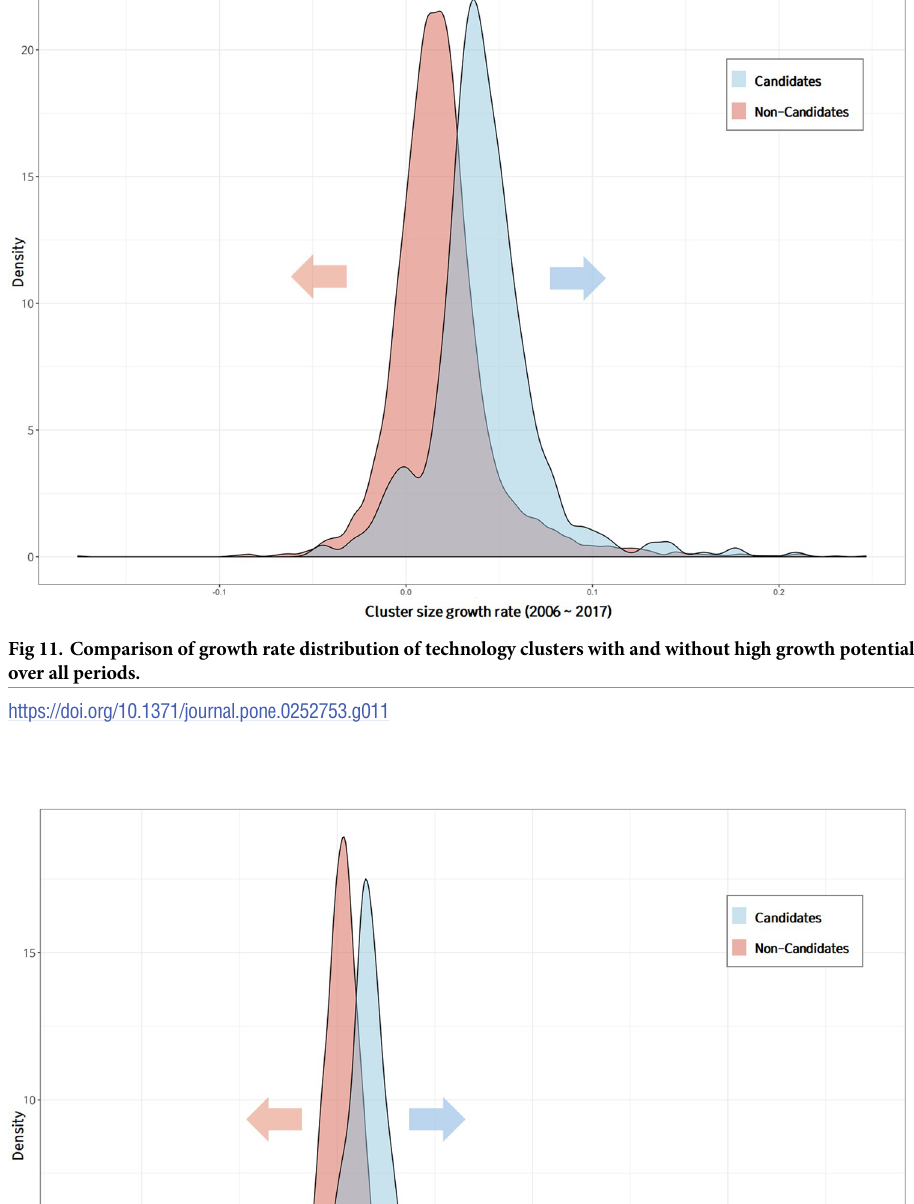
PLOS ONE | https://doi.org/10.1371/journal.pone.0252753 June 4,